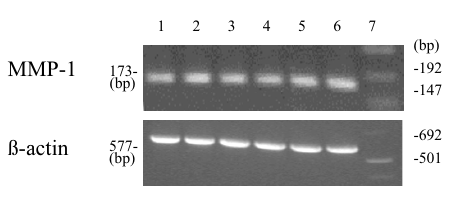
Figure 3 PCR products analysis of MMP-1 samples. 1, 2 and 3) con- trols; 4, 5 and 6) primary hernias; 7) standard